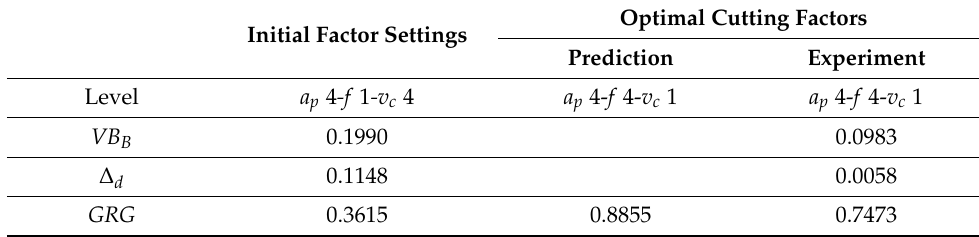
Table 8. Confirmation experiment (improvement in GRG =